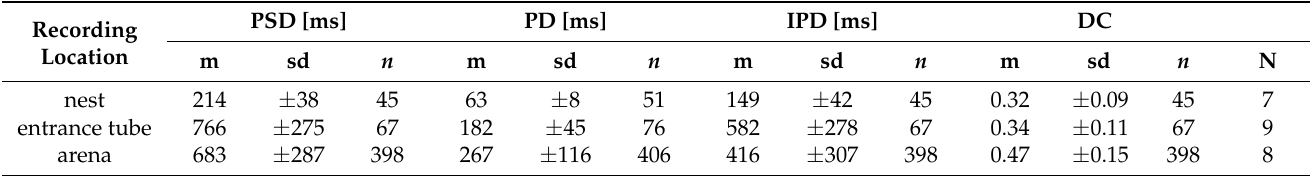
Table 1. Temporal patterns of foraging (nest) and guarding vibrations (entrance tube, arena) of A. ferruginea. Recording